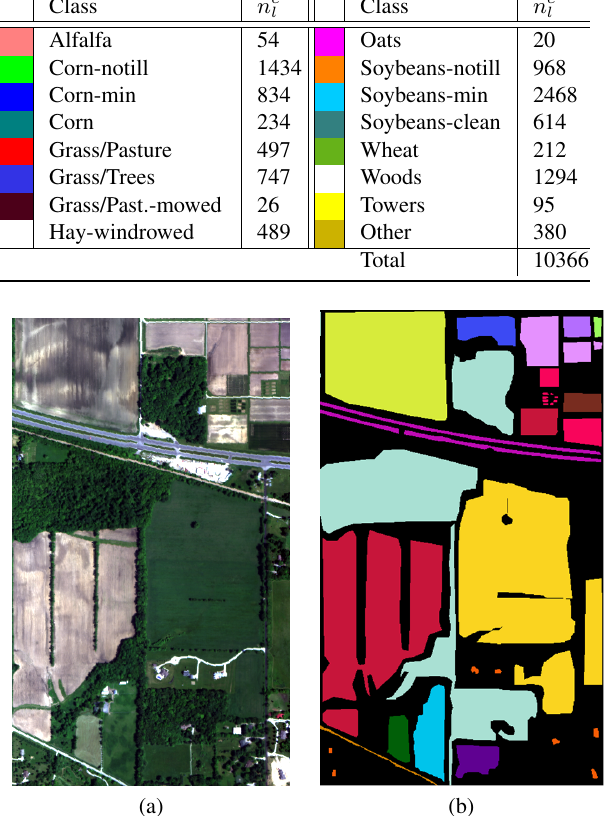
Figure 3: Indian Pines 2010 SpecTIR data.(a) RGB composition and (b) Ground truth (for color legend, see Tab. 2). Unlabeled samples are in black.